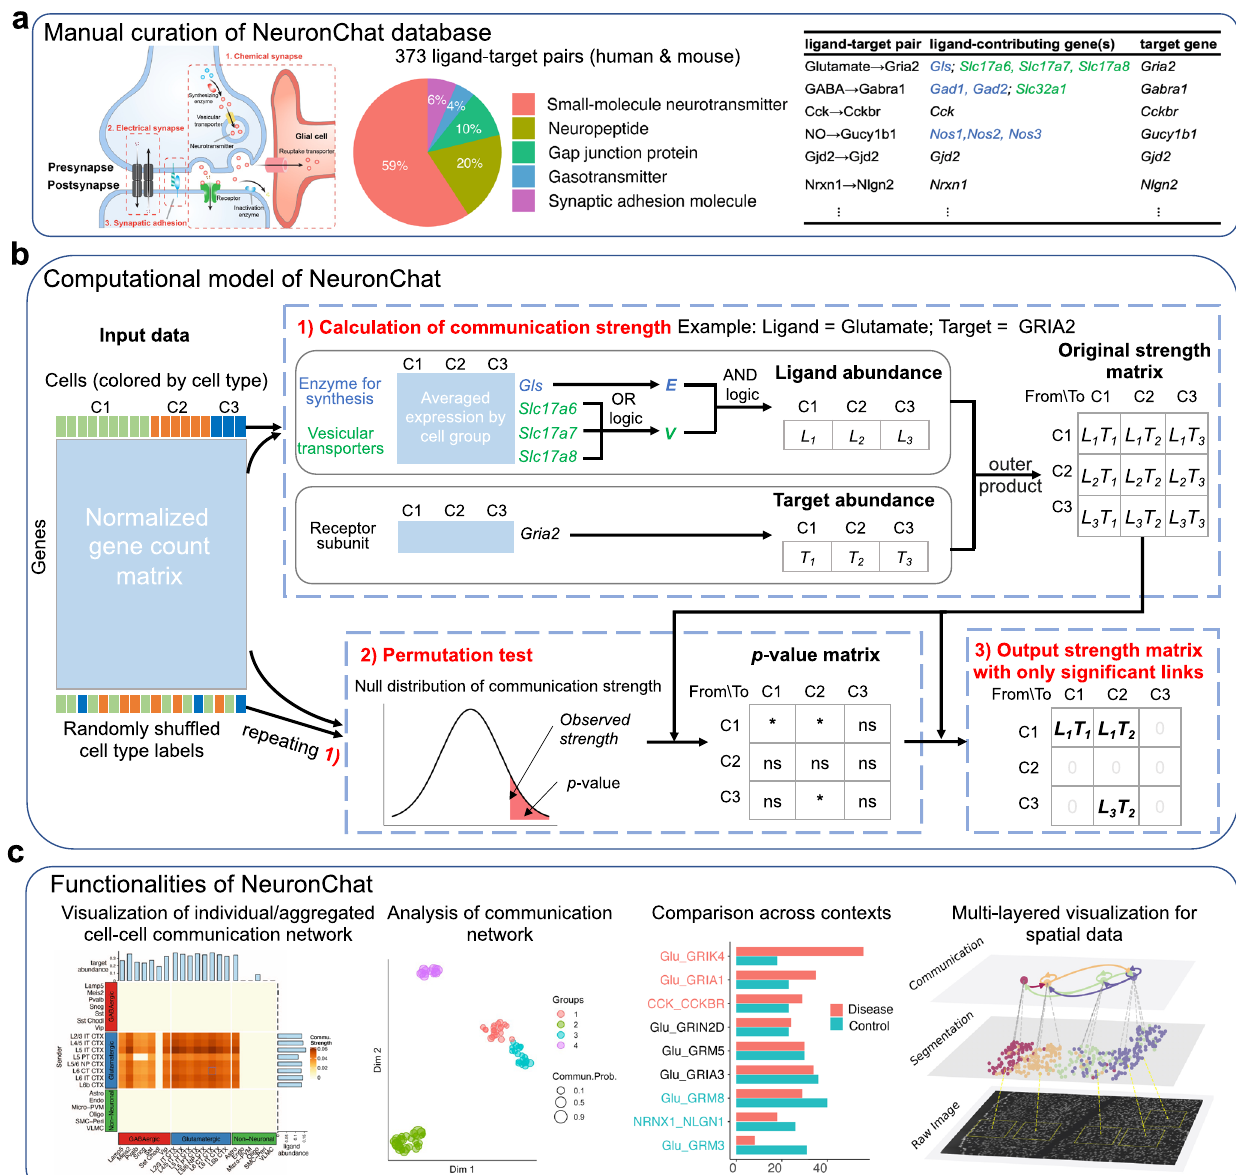
Fig.1|OverviewofNeuronChat.a OverviewofNeuronChatdatabase.NeuronChat database includes ligand-target pairs required for chemical synapse, electrical synapse and synaptic adhesion (left panel). There are a total of 373 ligand-target pairs for both humanand mouse, curatedinto fi ve categories basedon the typeof the ligand (middle panel). The interaction pair list includes the ligand, target, and